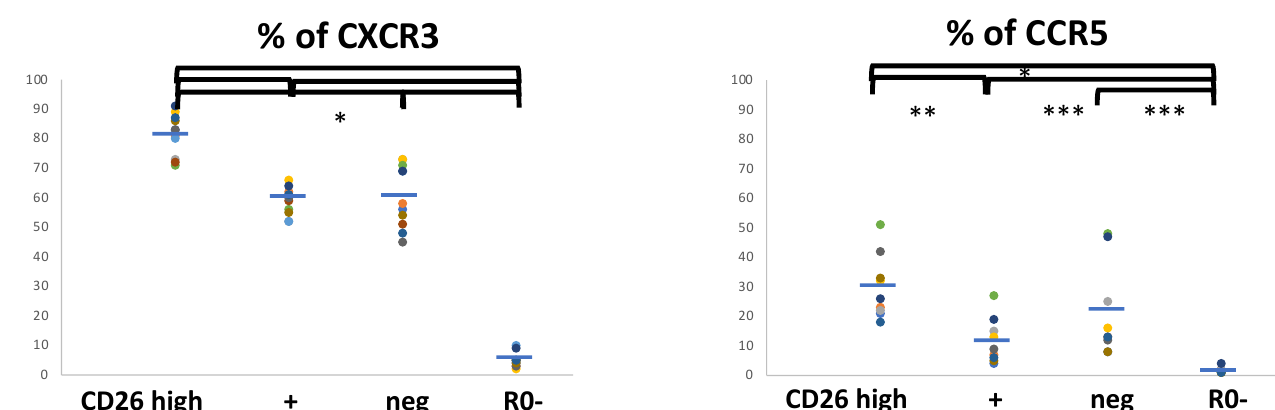
Figure 4. Markers of effector programs